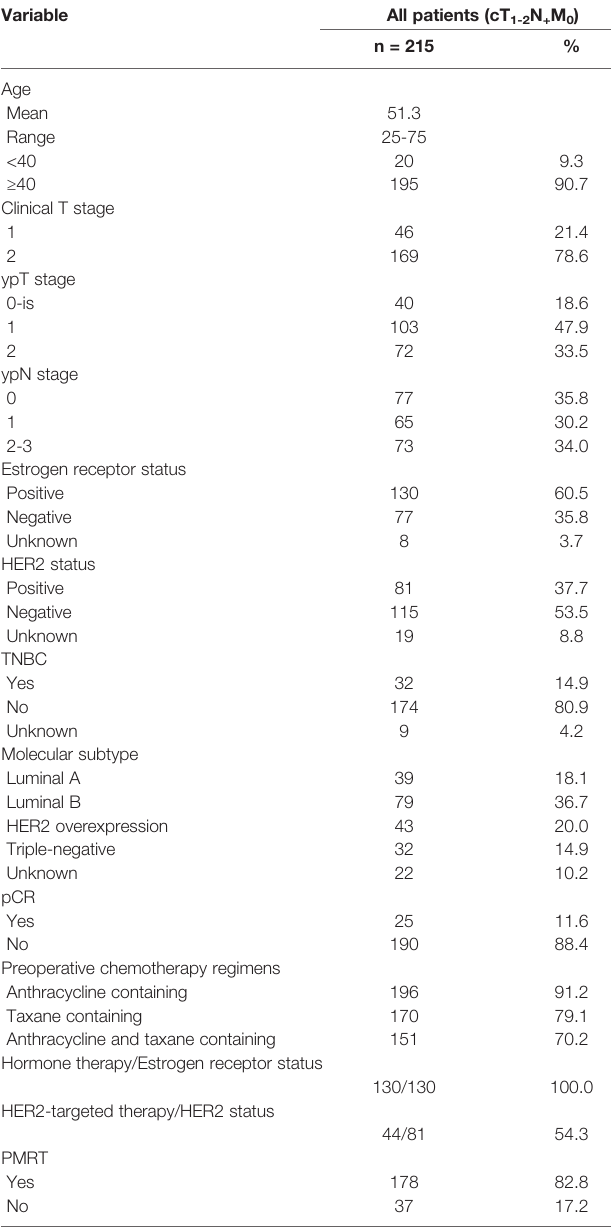
TABLE 1 | Clinical characteristics of all patients.